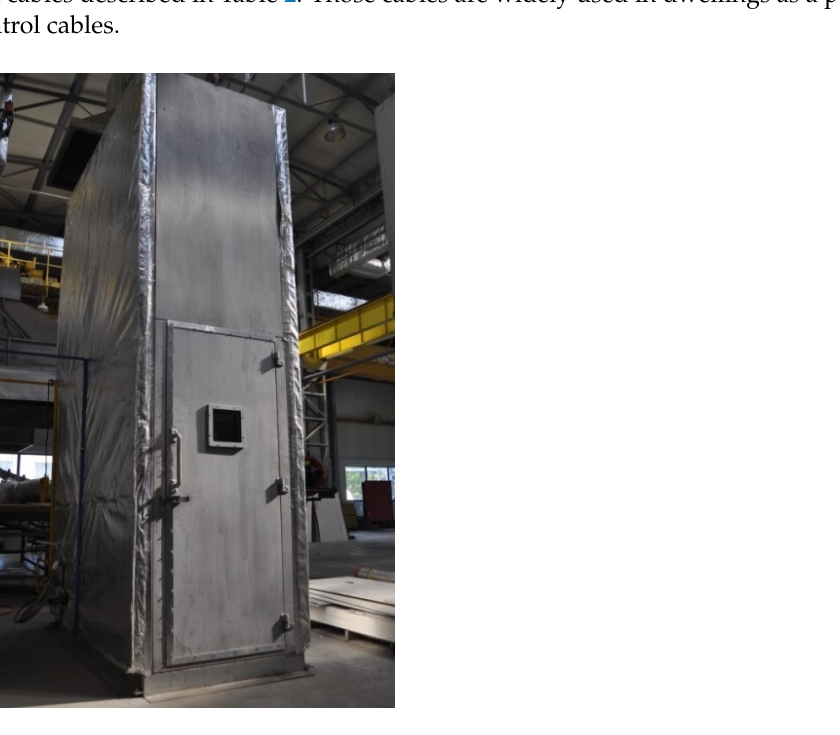
( b ) Figure 2. Cone calorimeter: ( a ) external view on the test apparatus, ( b ) cable specimen during the test, at the accredited Fire Testing Laboratory ITB in Pionki, Poland. Following the end-use application, a bunch of 19 pieces of PVC cable was tested in- side the chamber in their end-use application. The 3.6 m long pieces of cables were mounted on a 4 m test ladder. A nominal burner HRR level of 20.5 kW, airflow rate through the chamber of (8000 ± 800) L·min − 1 , and a white light detector were used [13]. The cone calorimeter tests were conducted on each presented cable (Table 2) at the set radiant heat flux of 50 kW·m − 2 to reflect real combustion conditions where rapid com- bustion is taking place. The cone calorimeter tests (Figure 2) were performed with hori- zontal specimens of the size of 100 mm × 100 mm. The surface of specimens was covered